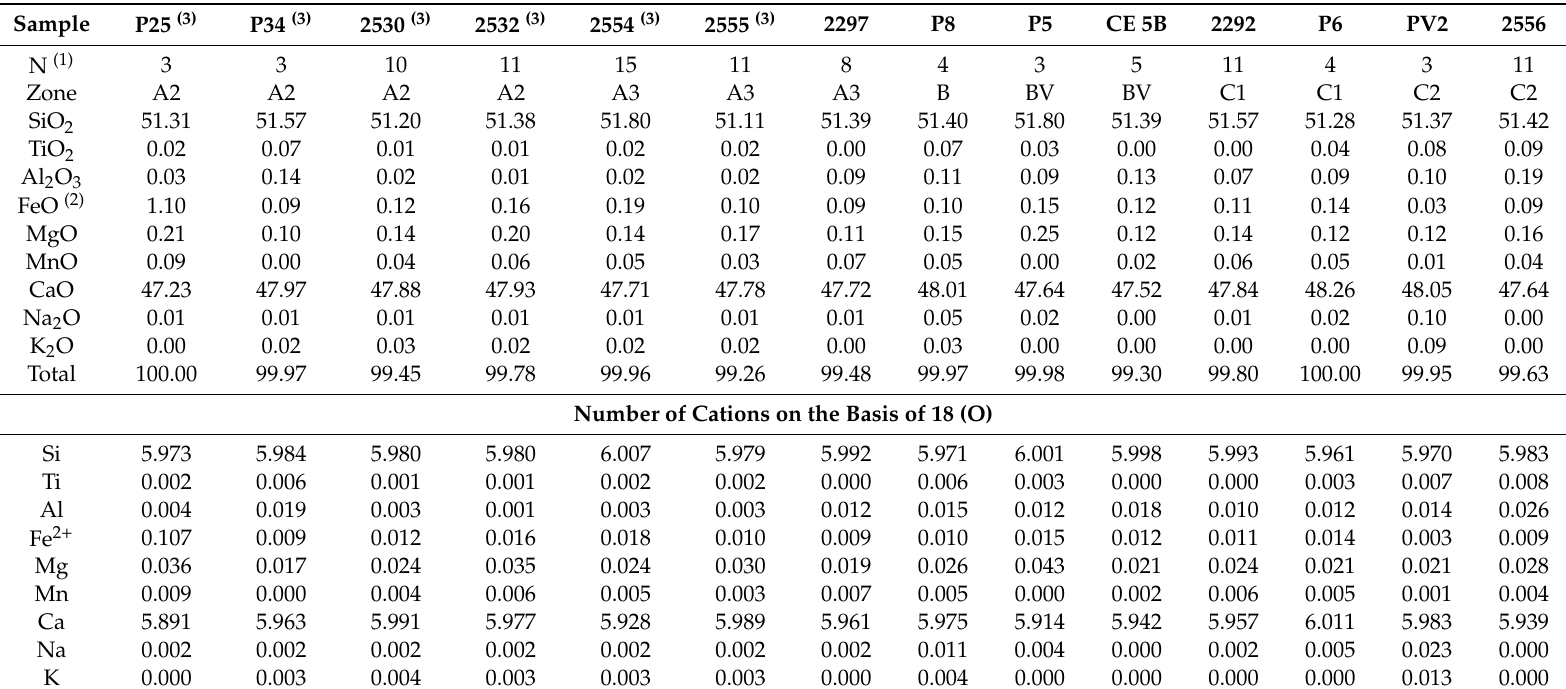
Table 7. Representative electron-microprobe analyses of wollastonite, M ă gureaua Va¸tei